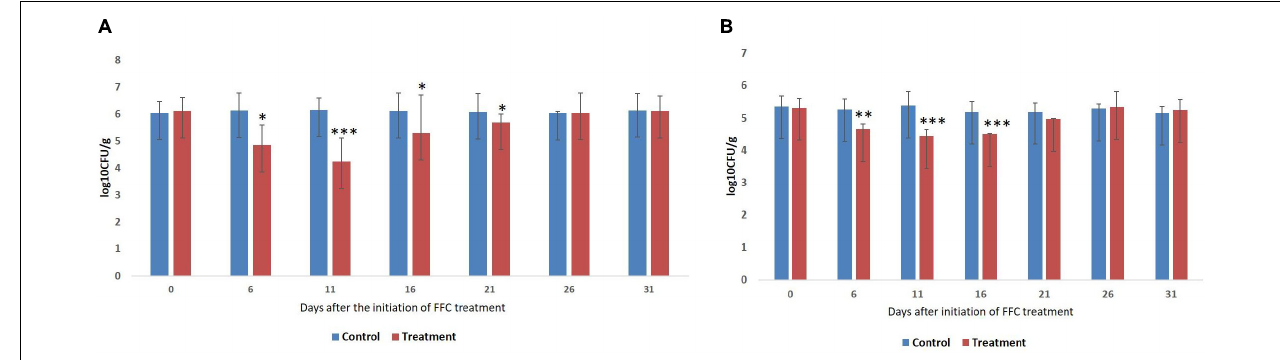
FIGURE 1 | Enumeration of gut bacteria during different days of therapeutic exposure. (A) Enumeration of total viable counts of gut bacteria. (B) Enumeration of presumptive vibrio counts. Average log 10 CFU per gram of gut tissue ± SE is shown in Y-axis. P -values less than 0.05, 0.01, and 0.001 are summarized with one, two, and three asterisks respectively, to represent the significant difference levels compared to the control animals. CFU, colony-forming units; FFC,